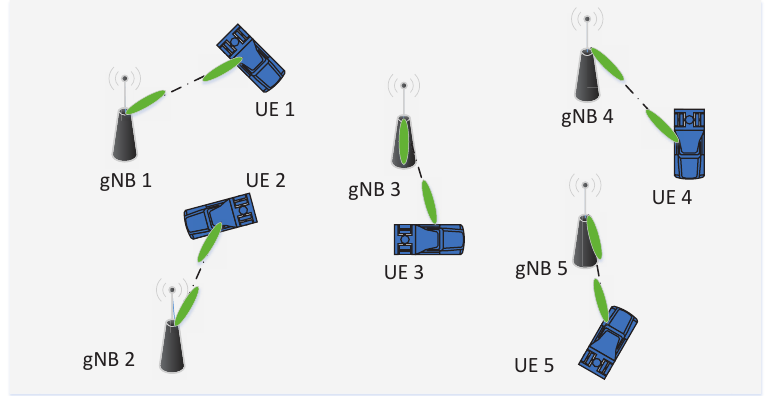
Figure 1. Multi-user single links in mobility